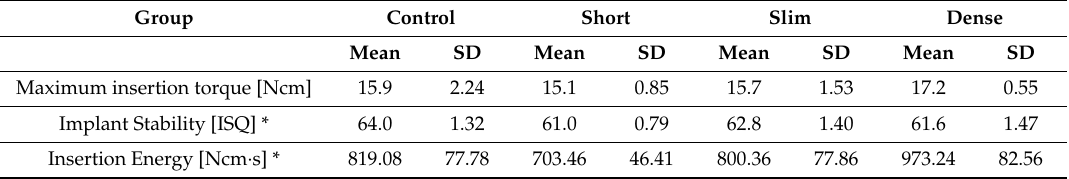
Table 2. Mean values and standard deviations (SD) for all parameters evaluated.